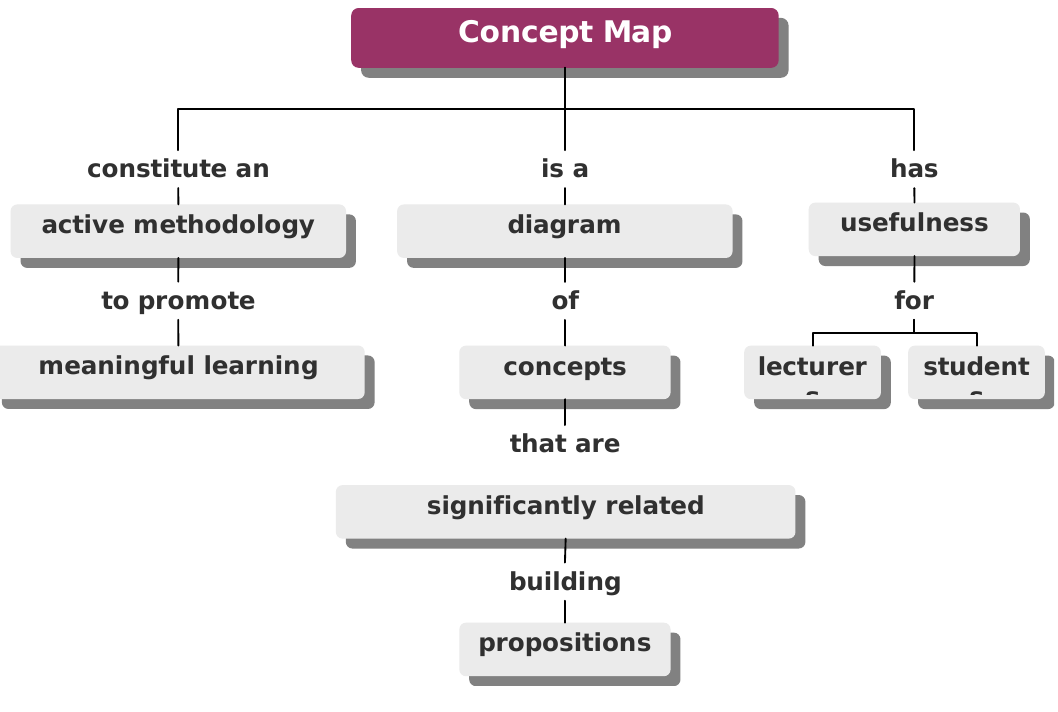
Figure 1. “Concept map about concept